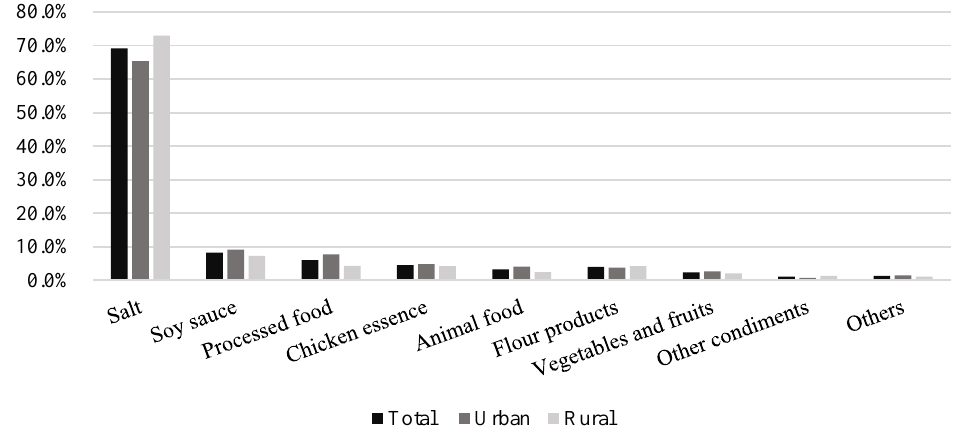
Figure 1. Proportion of sodium intake from various sources.